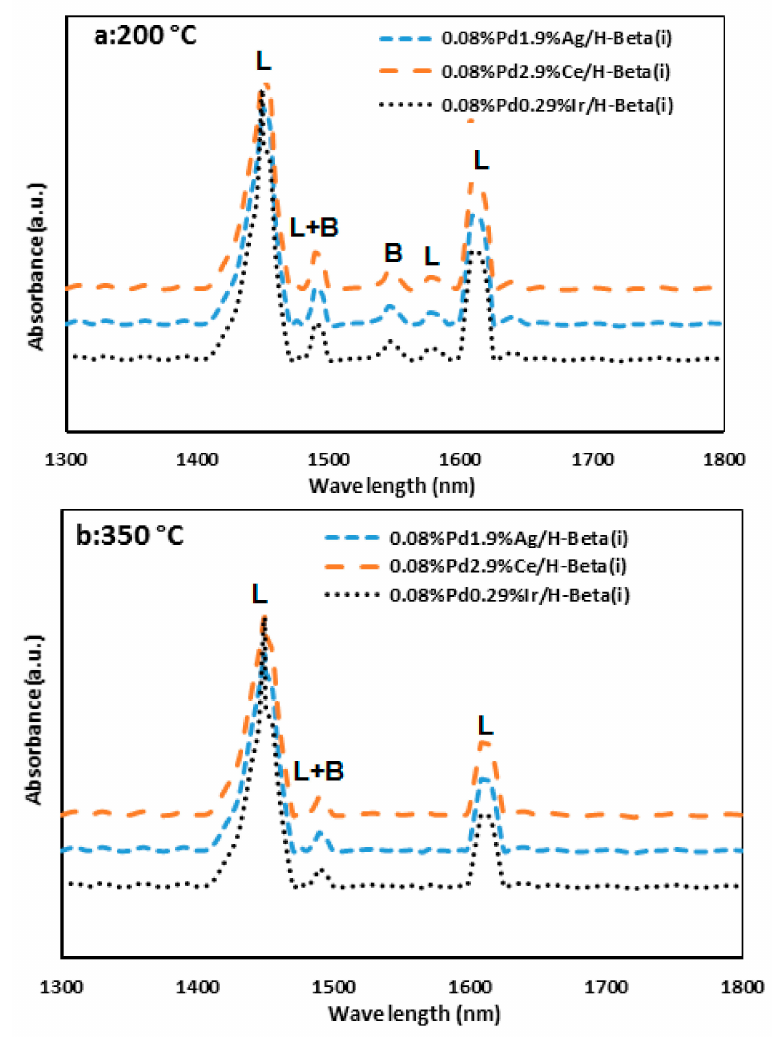
Figure 7. FTIR spectra of pyridine adsorbed on optimum catalysis ( a ) 200 ◦ C and ( b ) 350 ◦